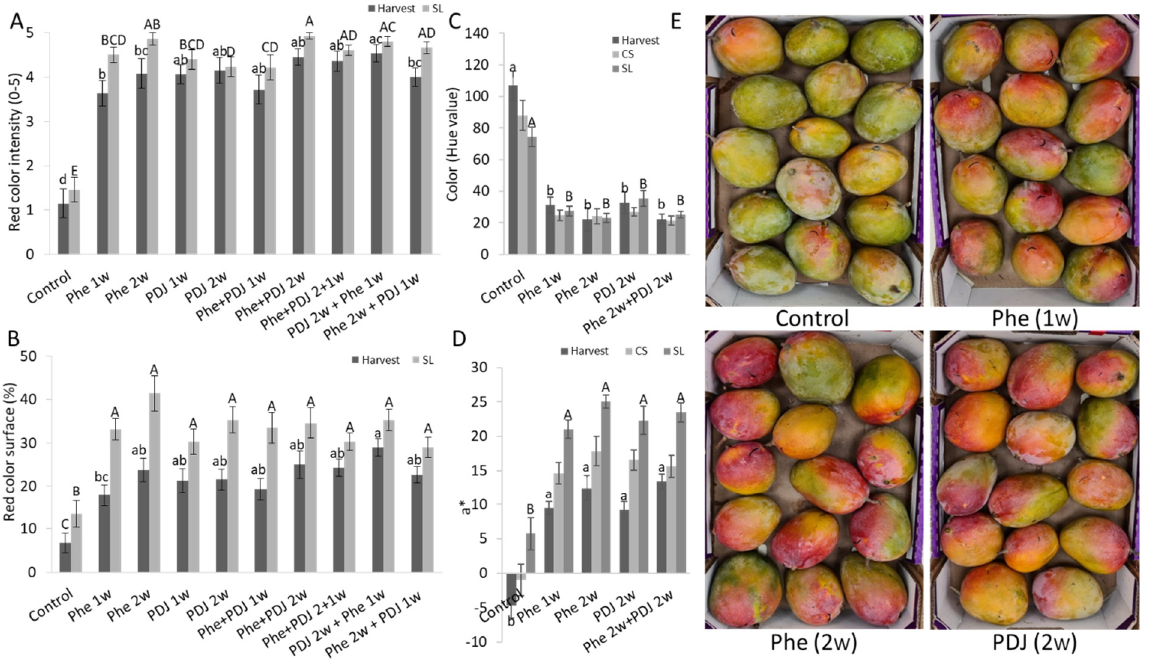
Figure 1. Red color evaluation of ‘Kent’ mango fruit peel. ‘Kent’ mango orchards were sprayed with 0.12% phenylalanine (Phe) or 0.2% prohydrojasmon (PDJ), one or two weeks preharvest. The fruit was evaluated at harvest (T0), after cold storage (CS, 3 weeks at 12 ◦ C), and after shelf life (SL, 7 days at 22 ◦ C). ( A ) Red color intensity (index 0–5). ( B ) Red surface area (% of fruit coverage). ( C ) Color (Hue value of the reddest point). ( D ) Green-red color range (a* value). ( E ) Representative pictures of ‘Kent’ mango boxes after shelf-life storage. Mean values and standard errors are presented. Statistical analysis was conducted for each time point separately (small or capital letters). Different letters represent a significant difference ( p ≤ 0.05).